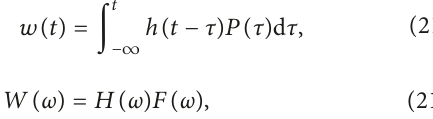
Figure 5: Different forms of stress